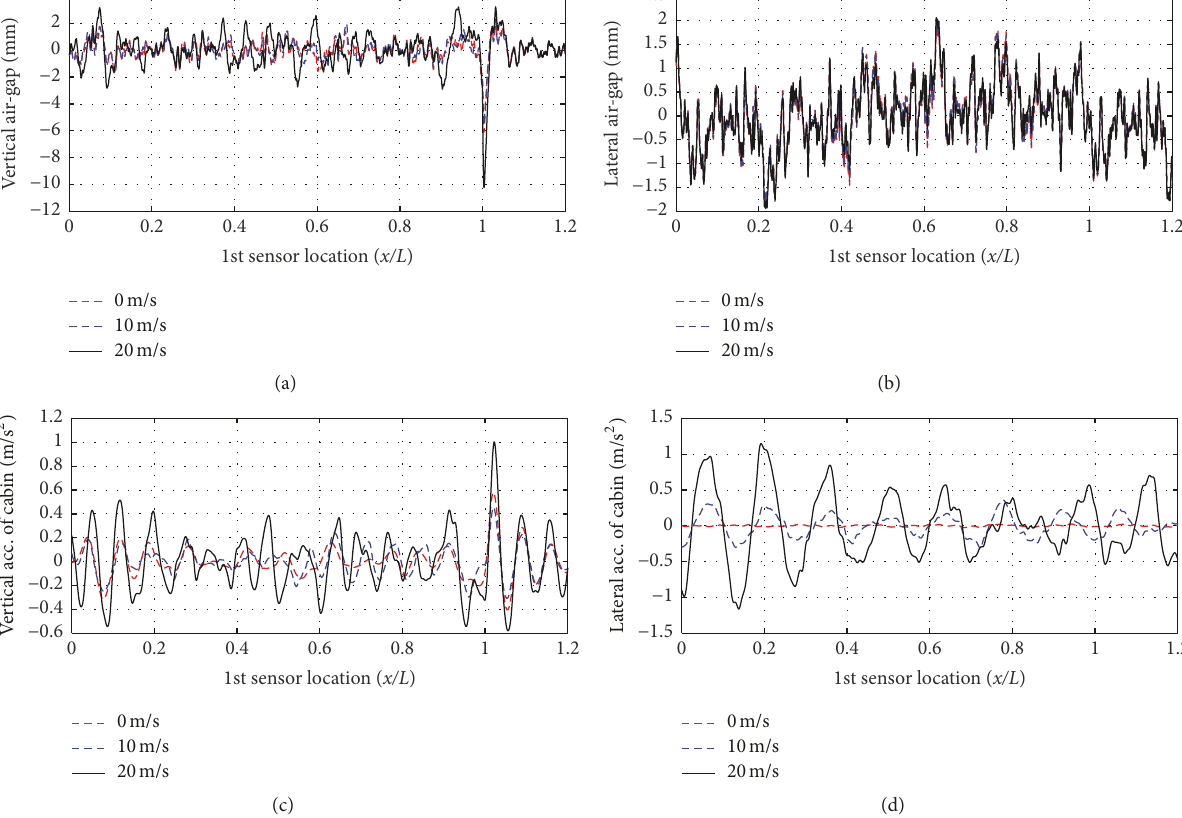
wind force is included in the equation of motion by the equivalent damping